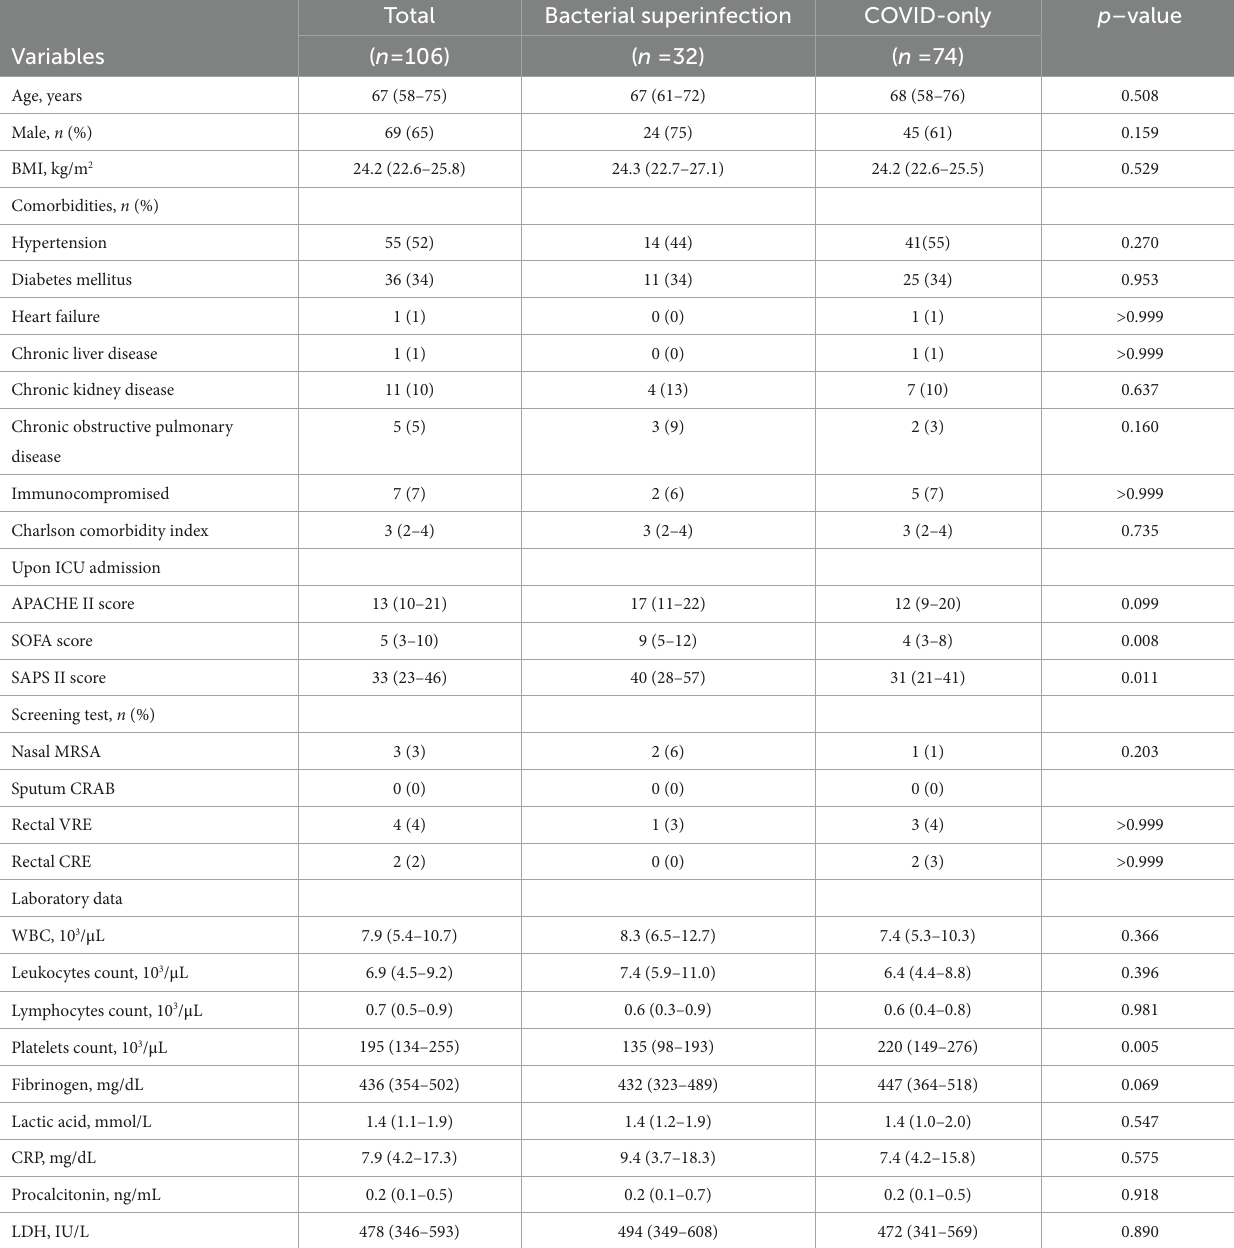
TABLE 1 Baseline and clinical characteristics of critically ill patients with